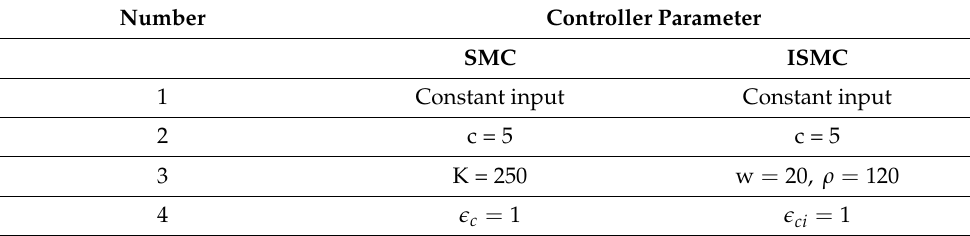
Figure 6. Total disturbance/perturbation.